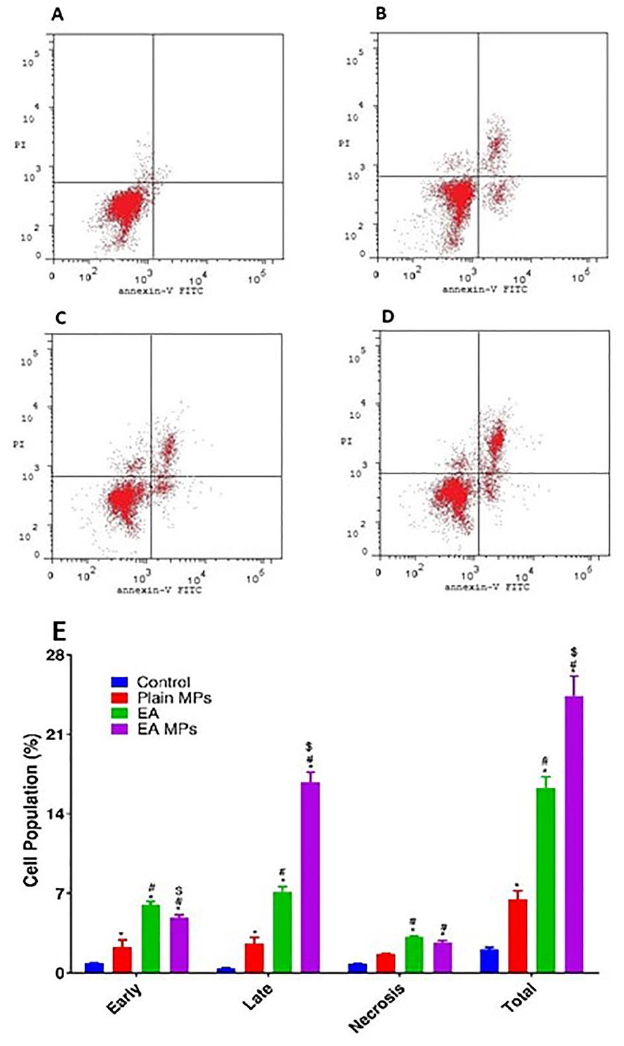
Figure 5. Impact of the EA MPs on the annexin-V fluorescein isothiocyanate (FITC) positive-staining HTC 116 cells. ( A ) Control, ( B ) plain MPs, ( C ) raw EA, ( D ) EA MPs, and ( E ) graphical presentation of early and late apoptotic, necrotic, and total cell death. * Significantly different from corresponding control at p < 0.05. # significantly different from plain MP at p < 0.05; $ significantly different from EA at p <